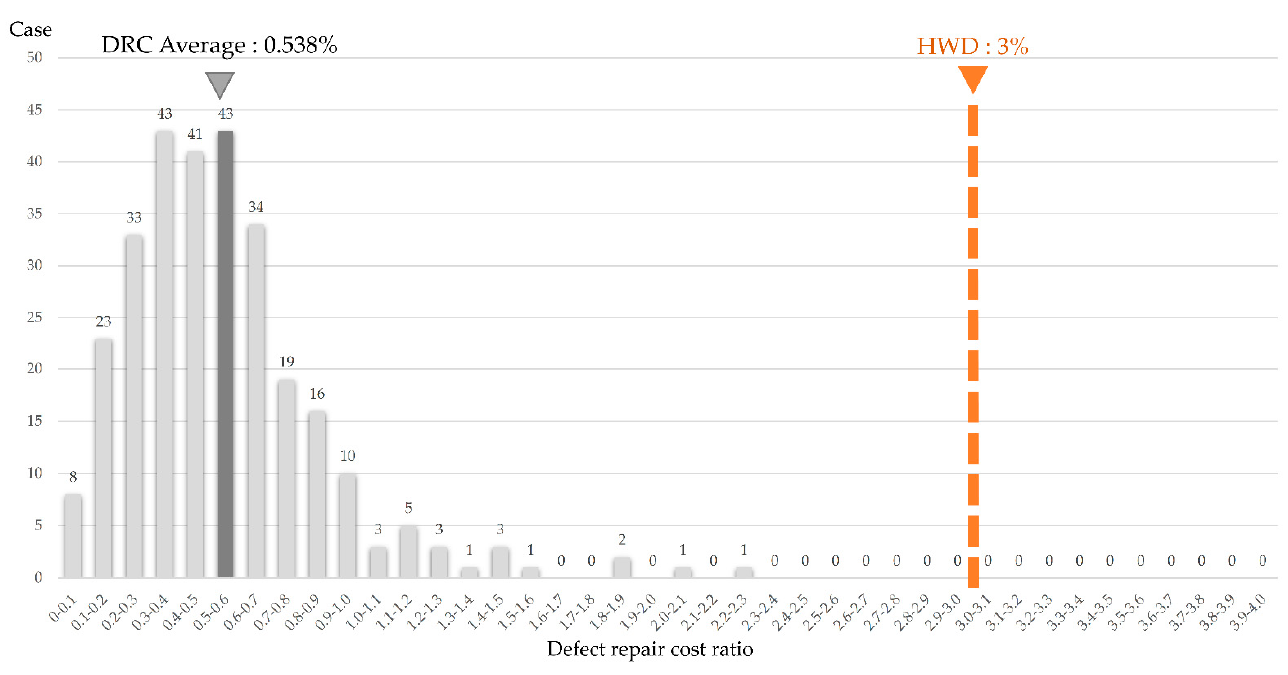
Figure 2. Comparison of DRC ratio and HWB ratio.